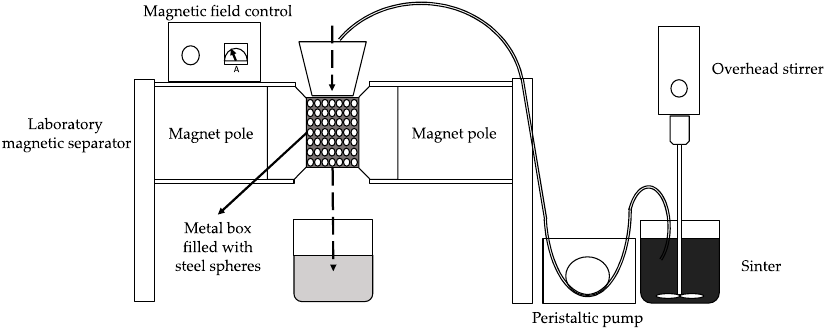
Figure 3. Carpco Model MWL-3465 laboratory, high-intensity, wet magnetic separator schematic diagram.